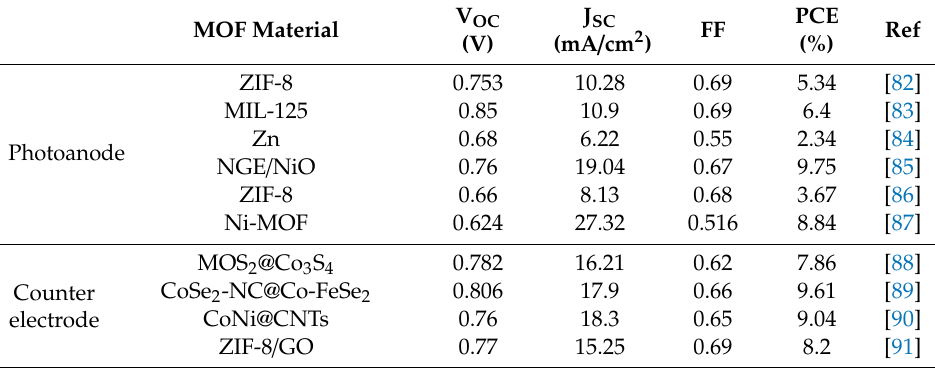
Photovoltaic performances of DSSCs with MOFs applied as the photoanode and counter